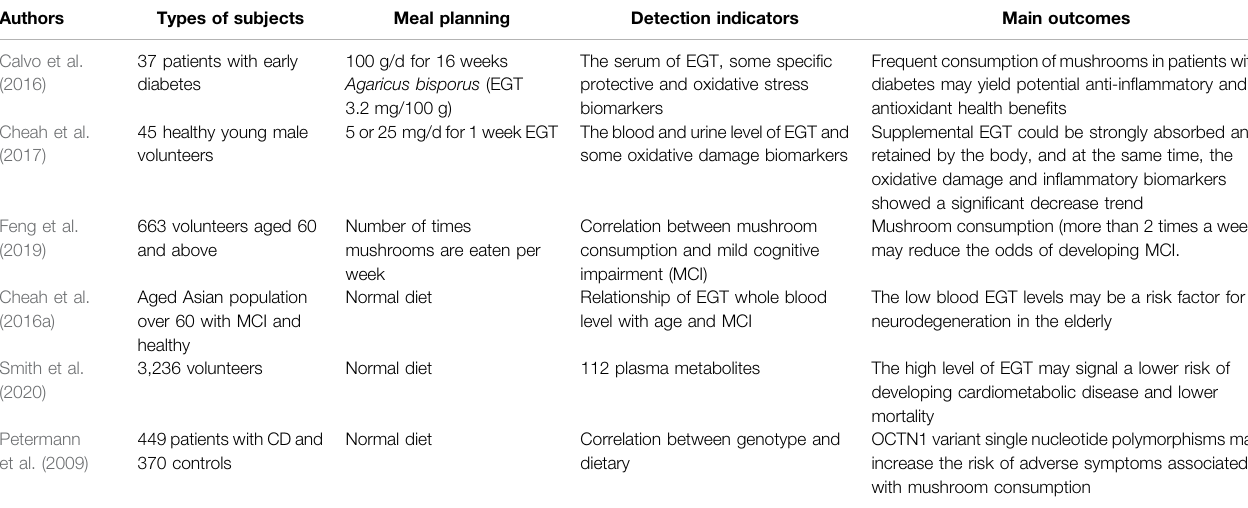
TABLE 1 | Summary of human survey studies on the association of ergothioneine or mushrooms with health and diseases.